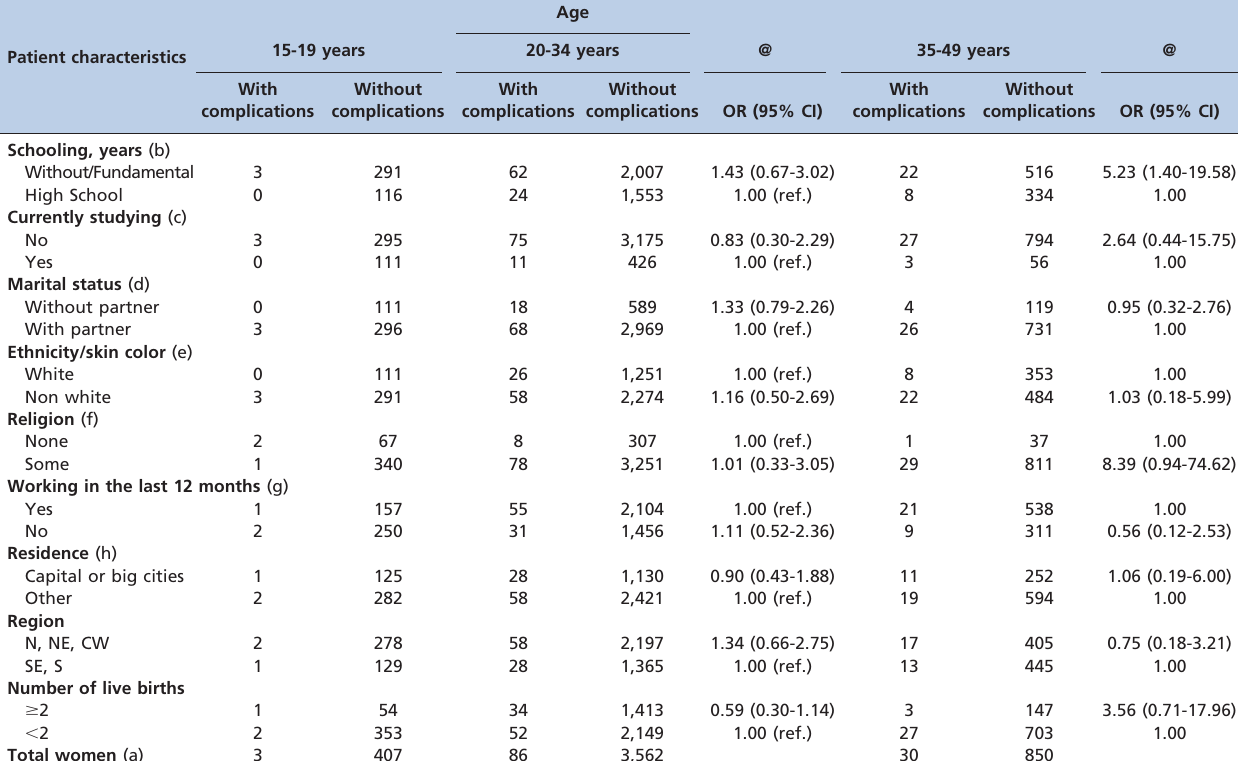
Table 4 - Crude estimated risk of maternal complications by age according to socio-demographic characteristics. DHS, Brazil,